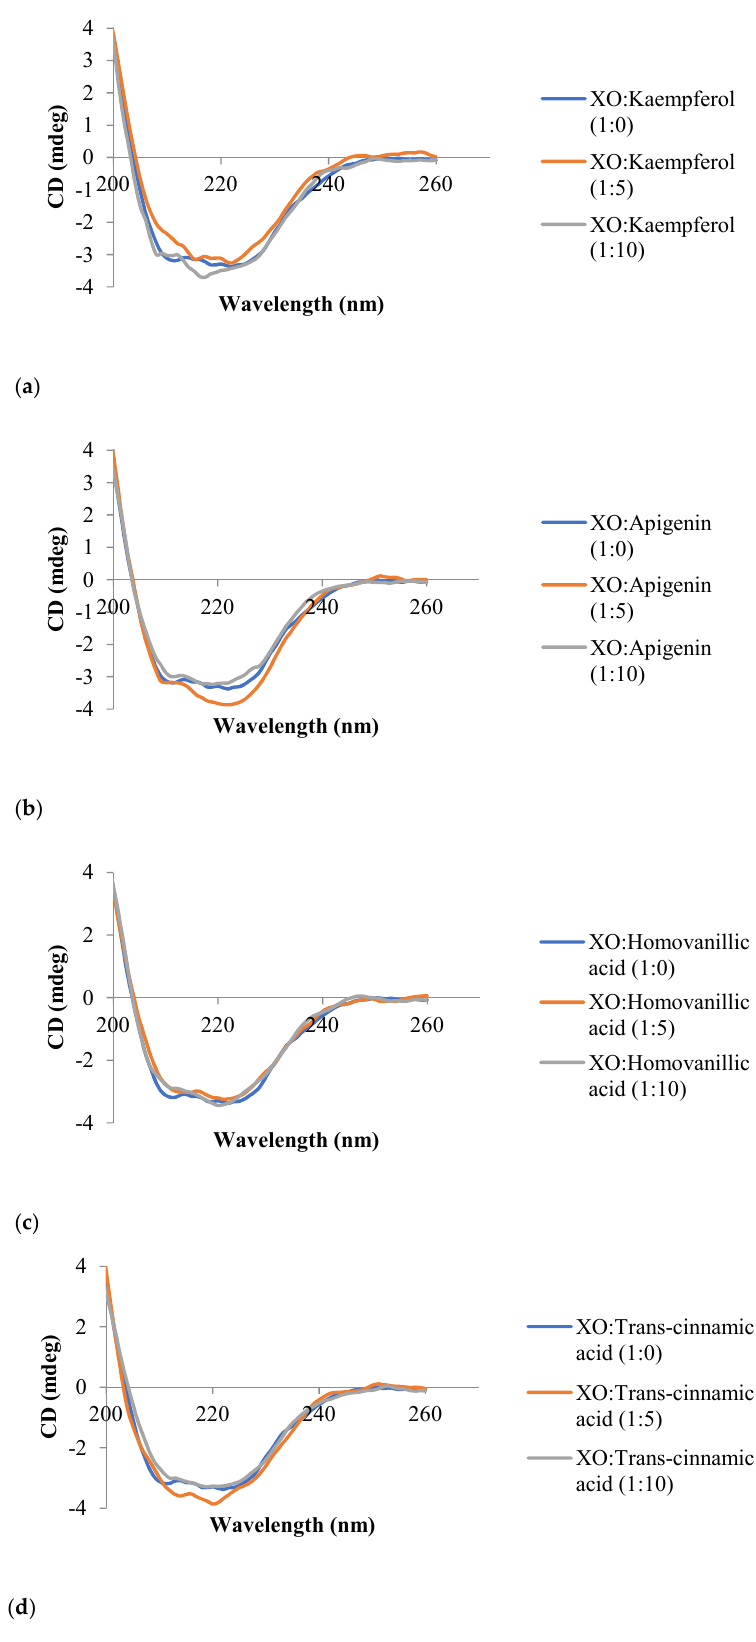
Figure 6. The CD spectra of the inhibitors ( a ) kaempferol, ( b ) apigenin, ( c ) homovanillic acid, and ( d ) trans -cinnamic acid with the XO system at pH 7.5. The concentration of XO was 1.0 × 10 −6 mol L −1 , and the molar ratios of each inhibitor to XO were 1:0, 1:5, and 1:10. Table 3. The contents of secondary structures of free XO and inhibitor-XO systems (CD spectra) at pH 7.5.